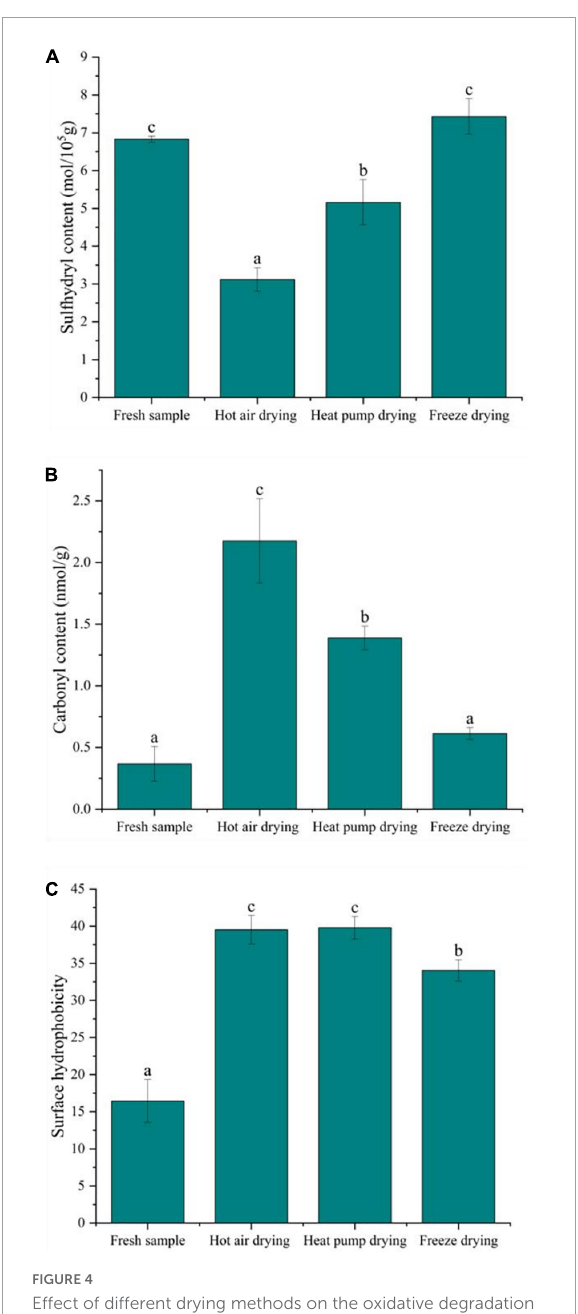
FIGURE4 Effect of different drying methods on the oxidative degradation properties of myofibrillar protein. (A) Sulfhydryl content; (B) carbonyl content; (C) surface hydrophobicity. Values represent the mean ± SD ( n = 3). Lower case letters indicate significance at p <